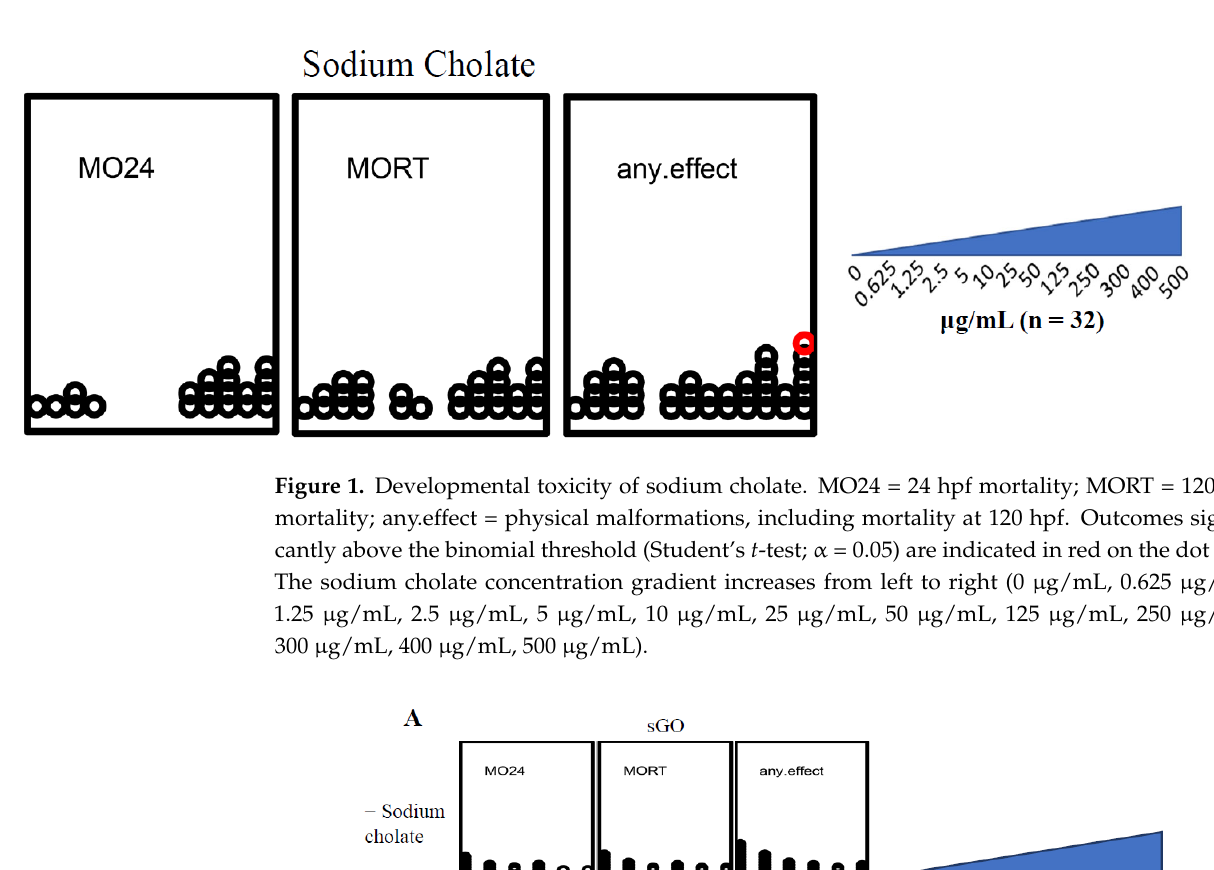
Figure 1. Developmental toxicity of sodium cholate. MO24 = 24 hpf mortality; MORT = 120 hpf mortality; any.effect = physical malformations, including mortality at 120 hpf. Outcomes signifi- cantly above the binomial threshold (Student’s t -test; α = 0.05) are indicated in red on the dot plot. The sodium cholate concentration gradient increases from left to right (0 μ g/mL, 0.625 μ g/mL, 1.25 μ g/mL, 2.5 μ g/mL, 5 μ g/mL, 10 μ g/mL, 25 μ g/mL, 50 μ g/mL, 125 μ g/mL, 250 μ g/mL, 300 μ g/mL, 400 μ g/mL, 500 μ g/mL).